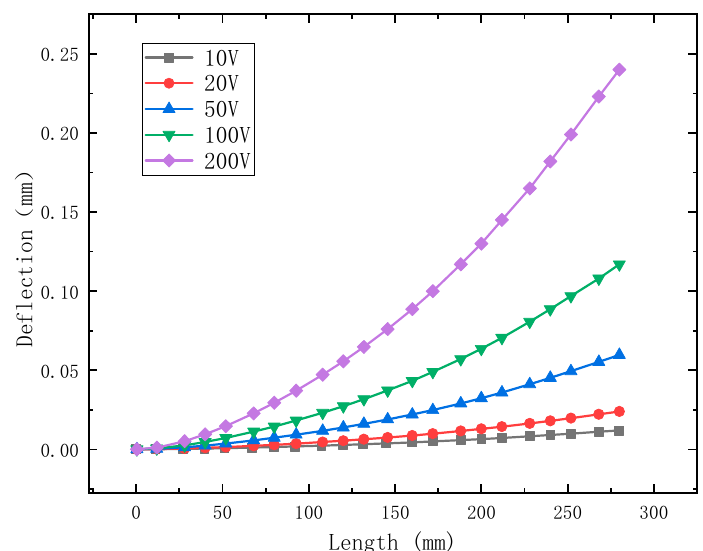
Figure 4. Deflection change of structure (1) under different voltages.